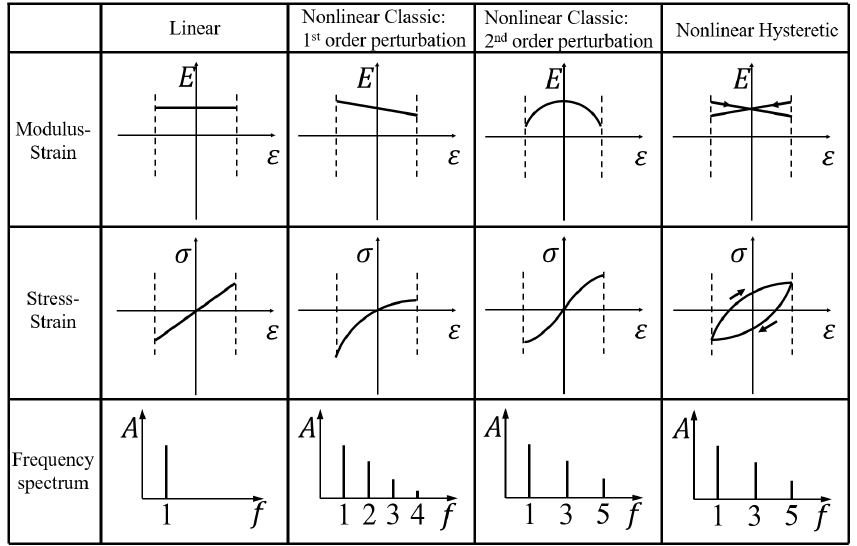
Figure 1. Schematic overview of the nonlinear contributions to the constitutive equation and its implication for dynamic one-dimensional wave propagation of a finite-amplitude monofrequency